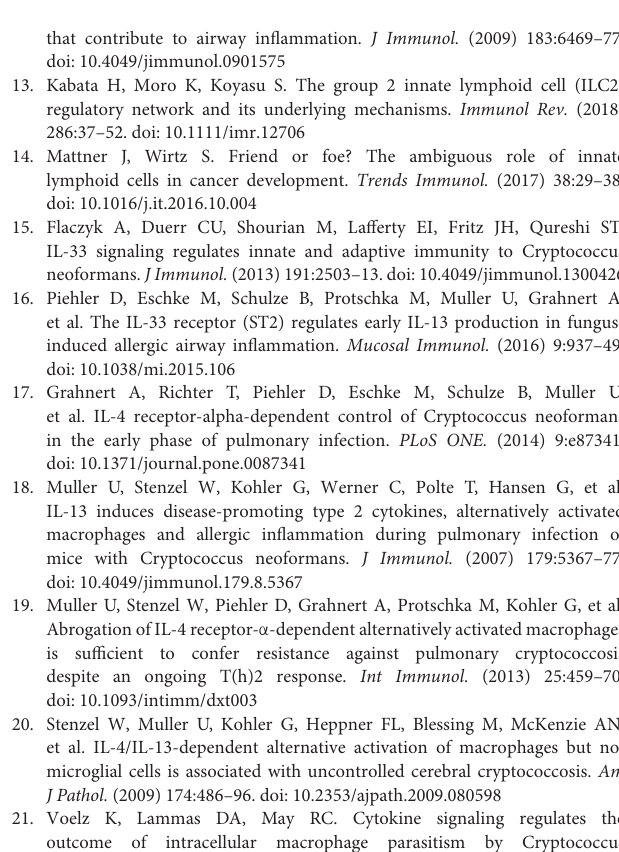
Supplemental Figure 4 | Gating strategies used in flow cytometry. (A) Gating strategy for Lin − /Thy1 + /ICOS + /KLRG1 + ILC2 in C. neoformans infected control and Tie2 cre Rora flox mice 14 dpi. (B) Gating strategy for CD11b + /CD64 − /Ly6g − /SiglecF + eosinophilic granulocytes